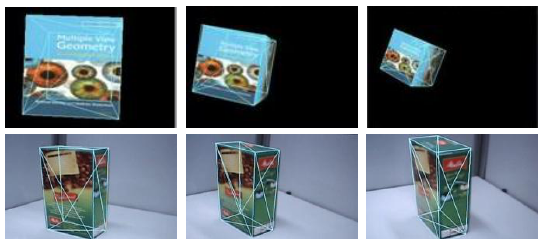
Figure 18. IPB tracking results for a synthetic sequence (top) and a real sequence